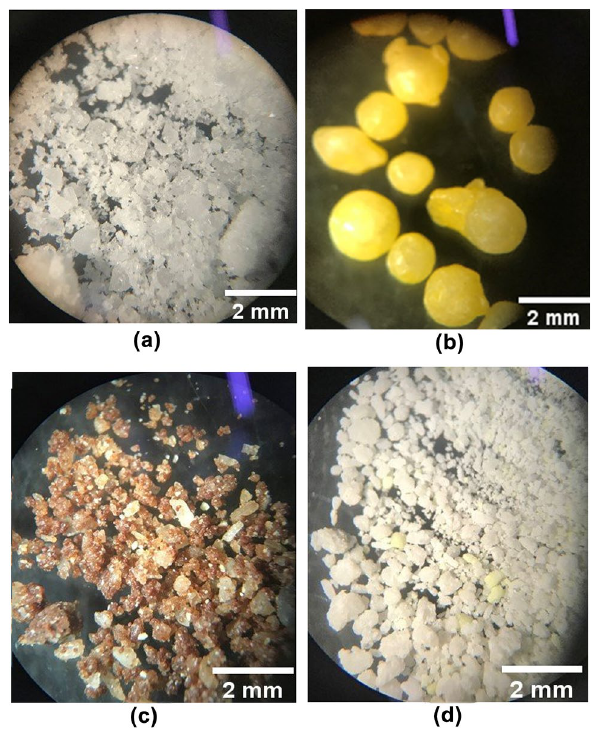
Figure 1. Stereoscopic microscope 40X magnification of nitrogenous products ( a ) Pure urea, ( b ) UP, ( c ) F16, and ( d ) F17.